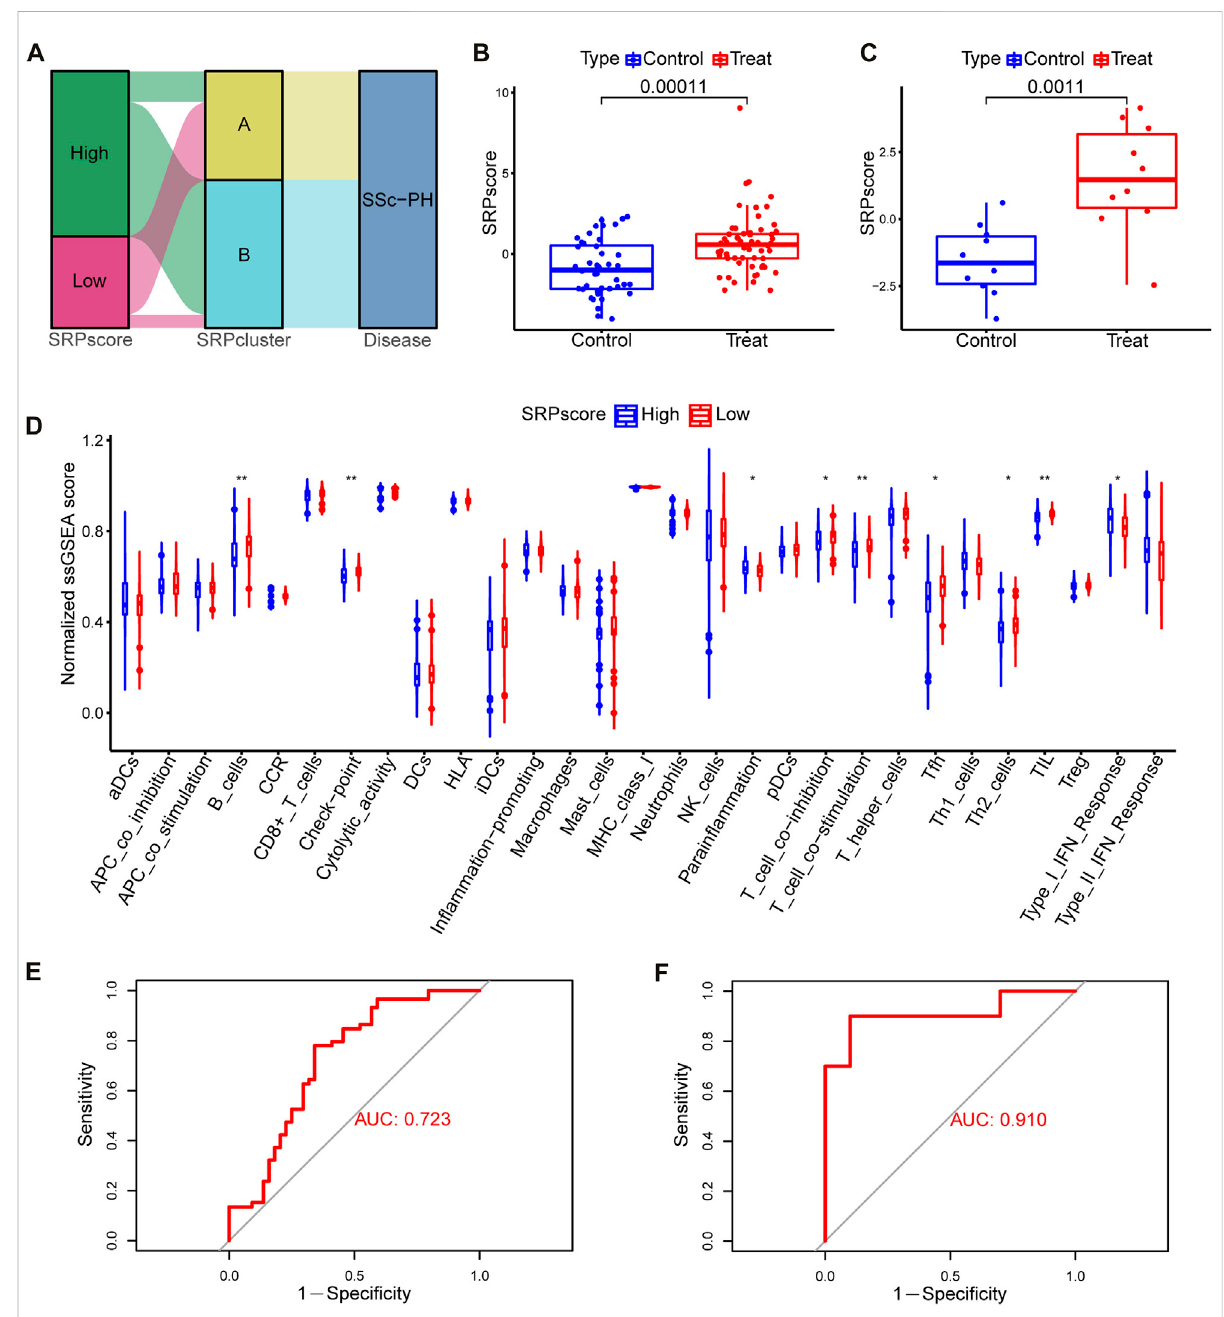
FIGURE 8 Construction and analysis of the SRPscore. (A) An alluvial plot showing SRPcluster, SRPscore, and disease changes. (B) SRPscore difference between the treatment and control groups in the training set. (C) SRPscore difference between the treatment and control groups in the test set. (D) DifferencesinnormalizedssGSEAscoresforthe29immunegenesetsbetweendifferentSRPscoregroups. (E) TheROCcurveoftheSRPscoreinthe training set. (F) The ROC curve of the SRPscore in the test set. *, p < 0.05; **, p < 0.01; ***, p <